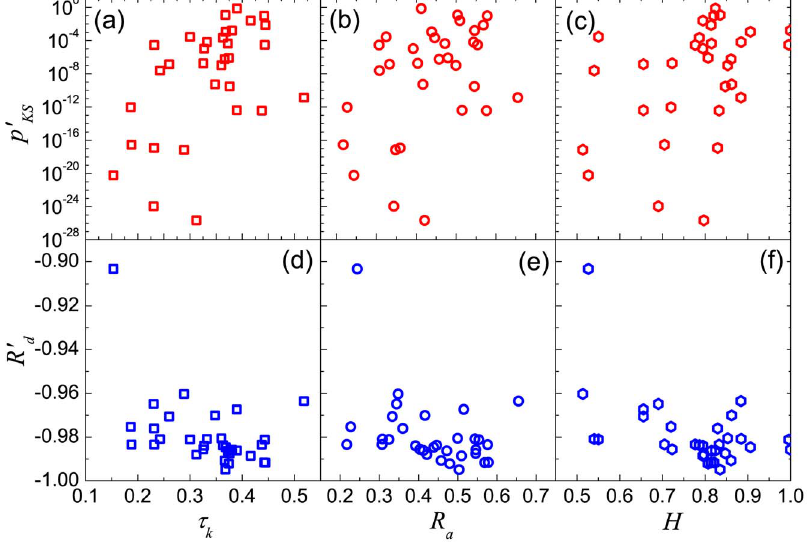
vs. t K , (b) p 0 vs. R a , (c) p 0 vs. H , (d) R 0 vs. t K , (e) R 0 vs. R a , (f) R 0 vs. H . Kendall’s Tau of these KS KS KS d d d